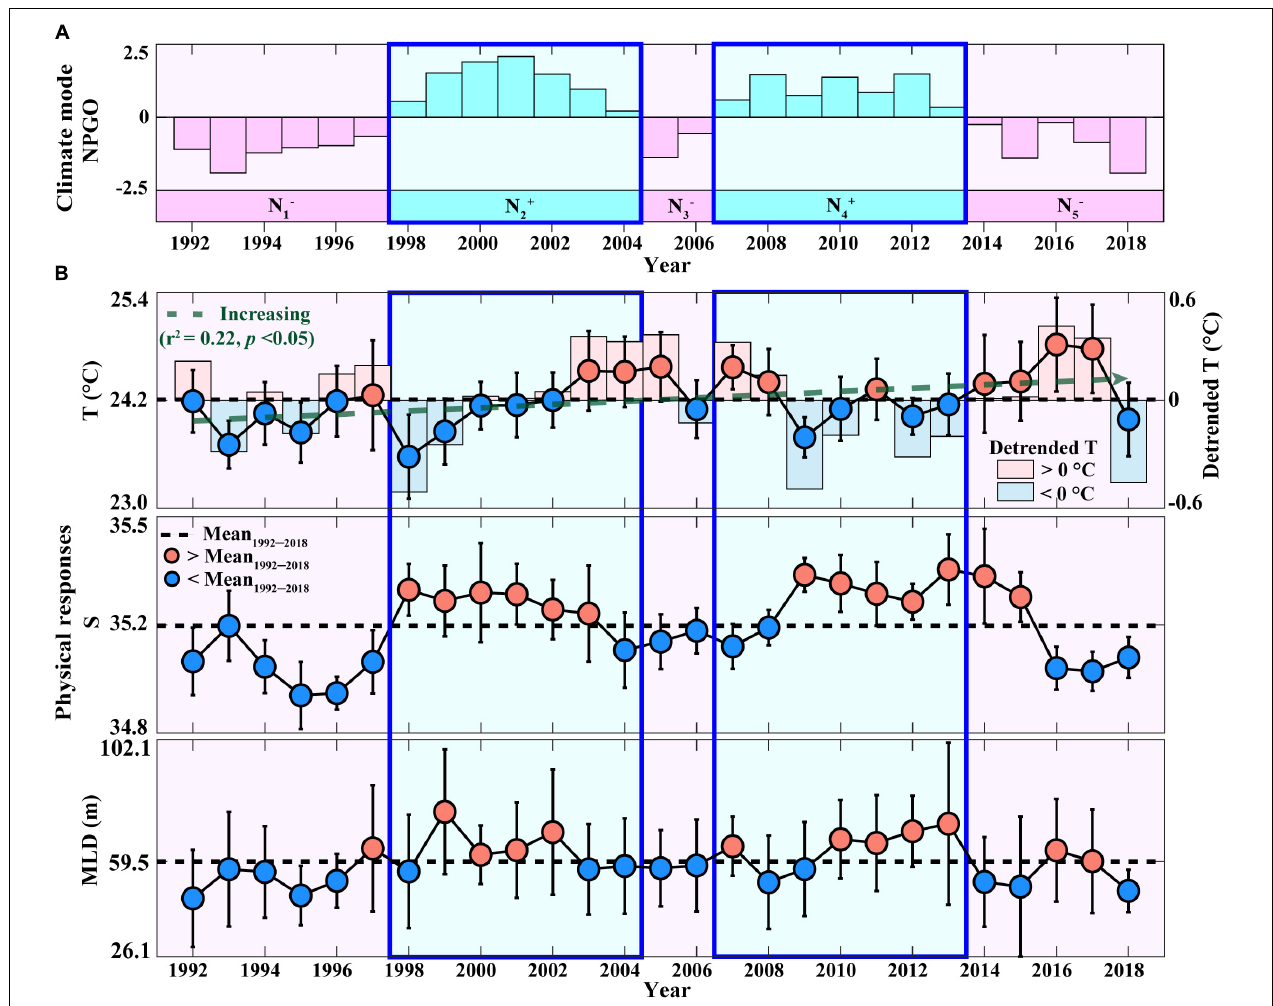
FIGURE 1 | Annual temporal variation in (A) climate mode (NPGO) and (B) physical parameters (T, S, and MLD) measured at Station ALOHA during 1992–2018. In panel A , pink bars indicate negative NPGO phases (N 1 − , N 3 − , and N 5 − ), and cyan bars indicate positive NPGO phases (N 2 + and N 4 + ). In panel B , the error bars indicate the STDs, the dotted black lines indicate the average during the study period, and the circles indicate annual averages exceeding (red) and lower (blue) than the study period averages. The dotted green line indicates a linear trend in T. The blue and red bars indicate a (–) sign and (+) sign of the detrended T, respectively. NPGO, the North Pacific gyre oscillation; MLD, mixed layer